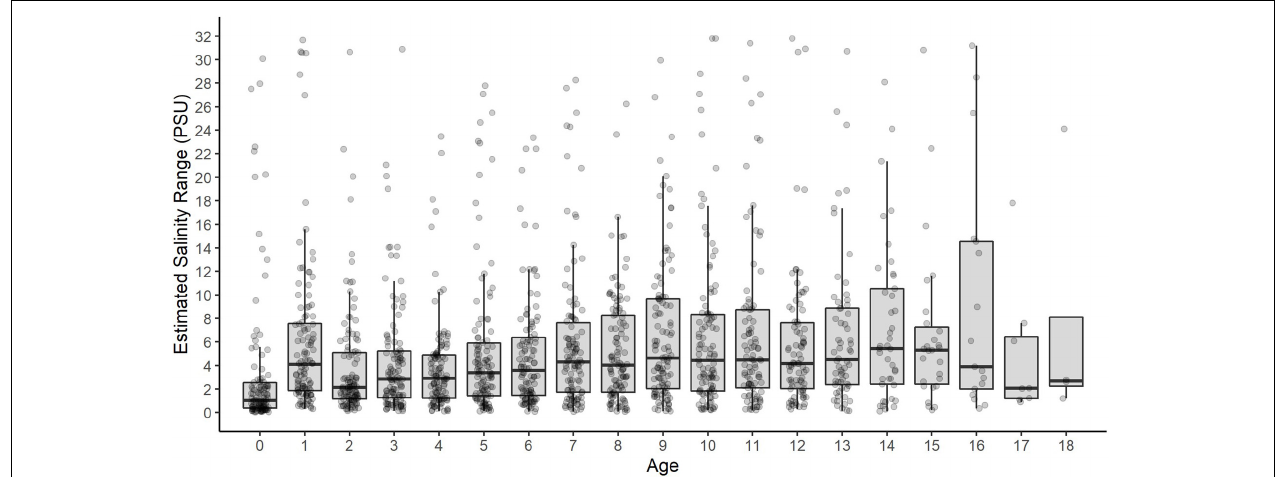
FIGURE 6 | Intra-annual variation (range) in salinity by age for each White Sturgeon. Points represent the salinity range for each year of each fish’s life (maximum-minimum salinity at that age). Box plots show the salinity ranges across all fish within each age class.